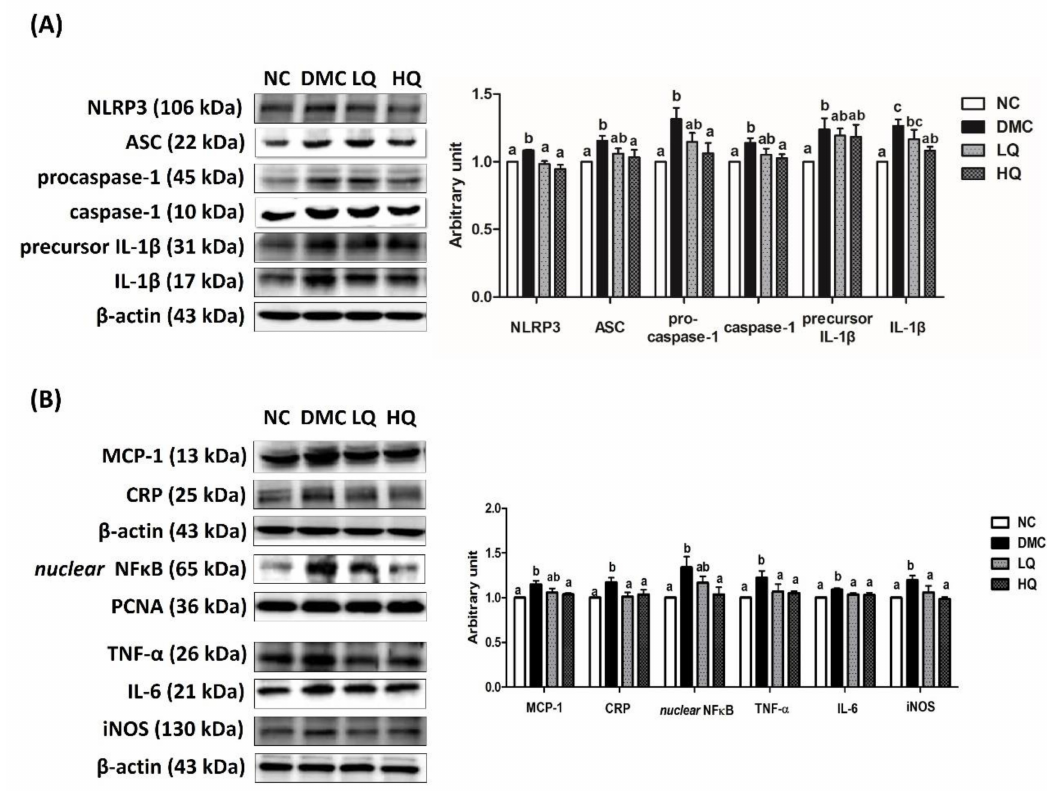
Figure 4. E ff ect of QAE on renal NLRP3 Inflammasome related hyper-inflammation in T2DM